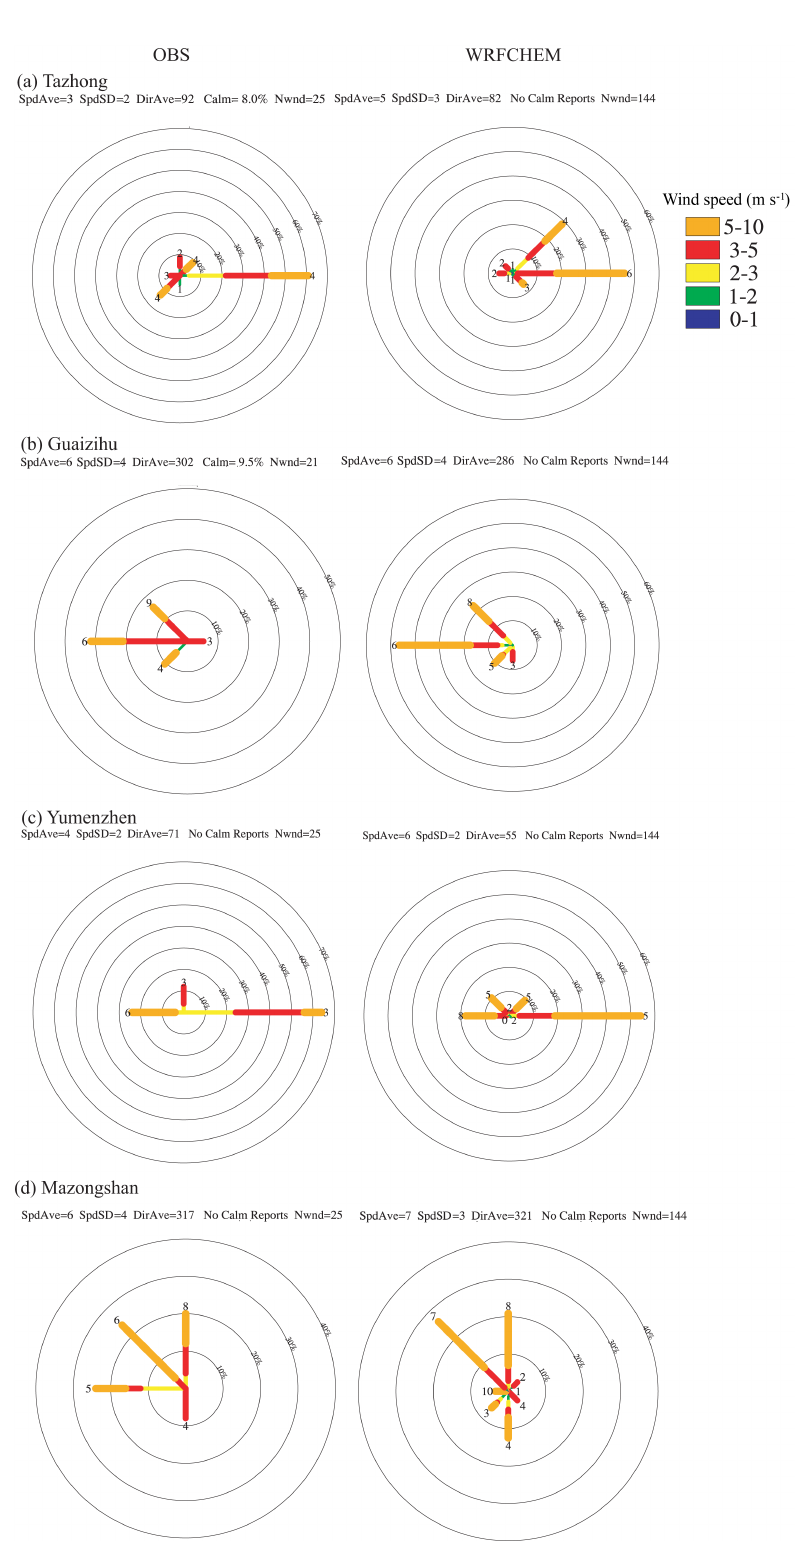
Figure 3. Wind rose diagrams at the four meteorological stations, Tazhong (a) , Guaizihu (b) , Yumenzhen (c) , and Maoyinbadao (d) , over the TD and GD during the simulation period from observations and the WRF-Chem model. The mean wind speed is included at the end of each directional